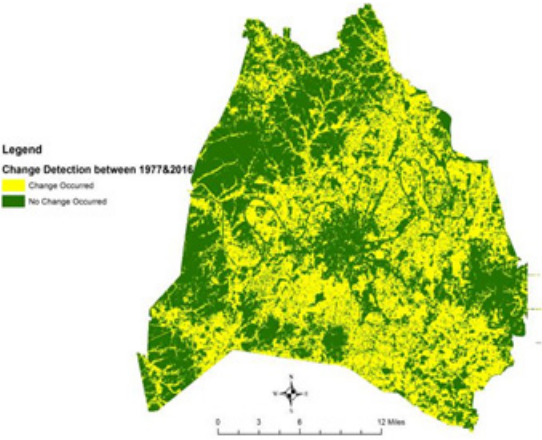
Fig. 9: Change detection areas between 1977 and 2016